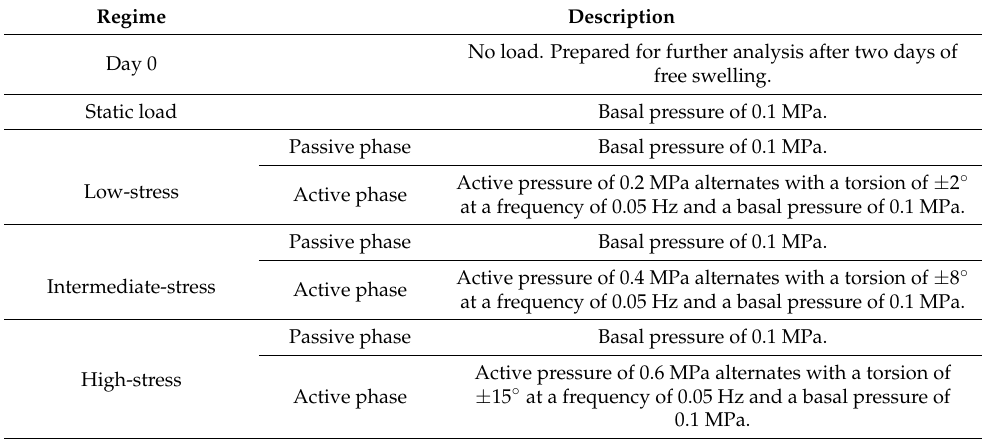
Table 1. Mechanical loading regimes applied to the explanted IVDs. Day 0 was used as a reference for all other regimes; “static load” refers to the static mechanical loading regime, and “low-stress”, “intermediate-stress” as well as “high-stress” all refer to the complex dynamic mechanical loading